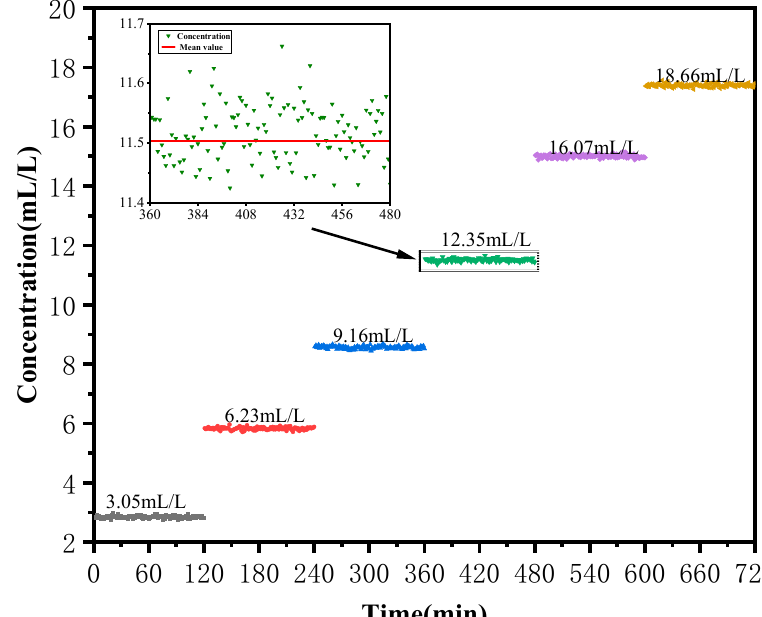
Figure 11. Experimental results for the measurements. Table 1. Specific measurement data.